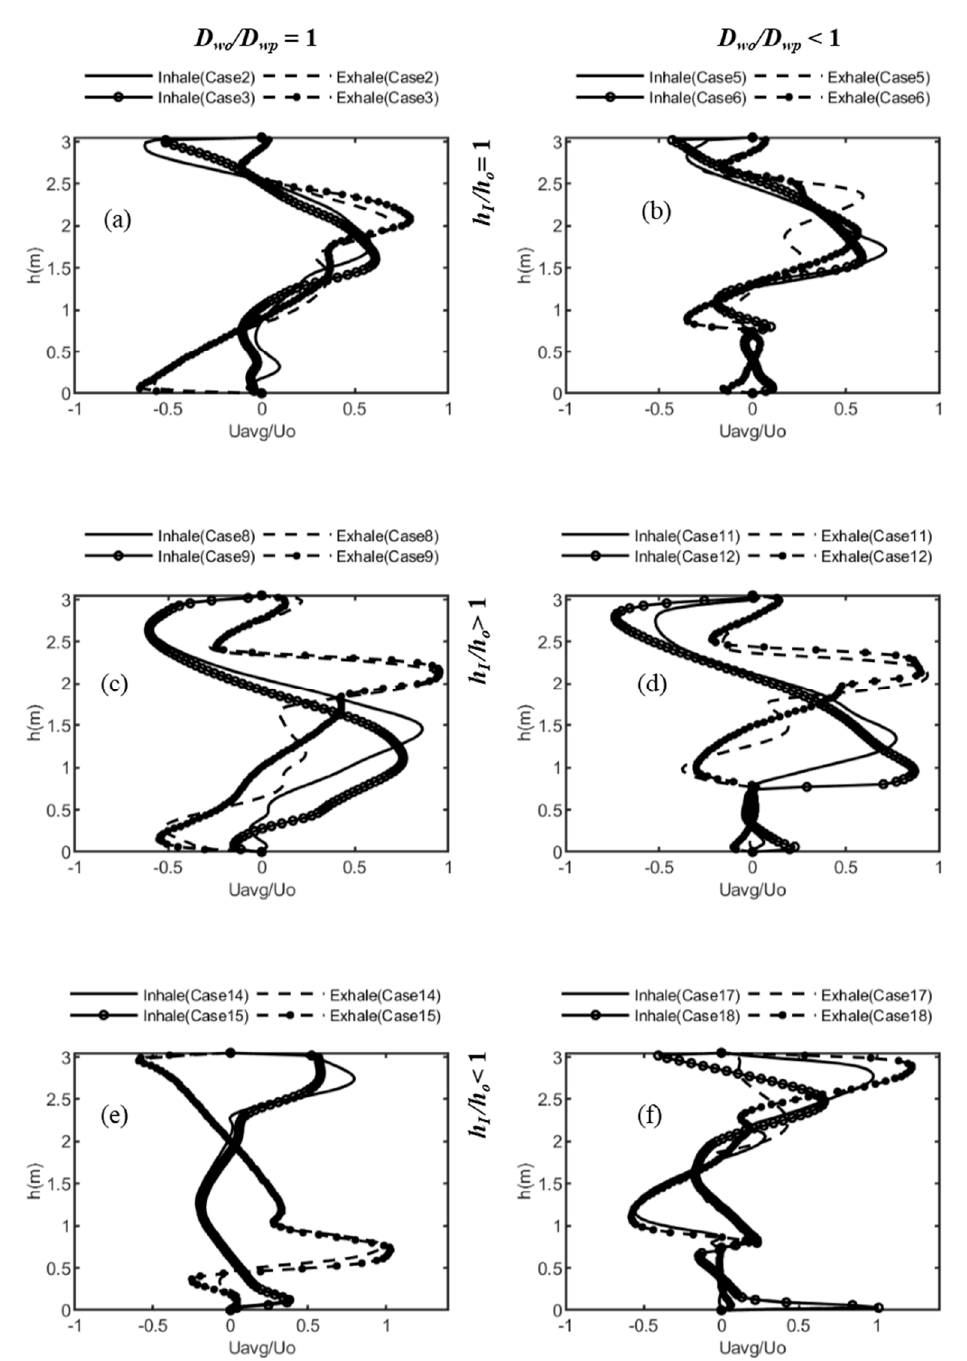
Figure 4. Average velocity line plots; solid and dotted lines are the normalized velocities across the height of the room at exhale ( x = 1.1 m) and inhale ( x = 3.05 m) locations, respectively; lines without markers are for ACH = 5 and those with markers are for ACH = 7; ( a ) cases 2 and 3, ( b ) cases 5 and 6 ( c ) cases 8 and 9, ( d ) cases 11 and 12, ( e ) cases 14 and 15, and ( f ) cases 17 and 18. Table 2. Standard deviation and skewness to assess the changes from exhale to inhale zones.